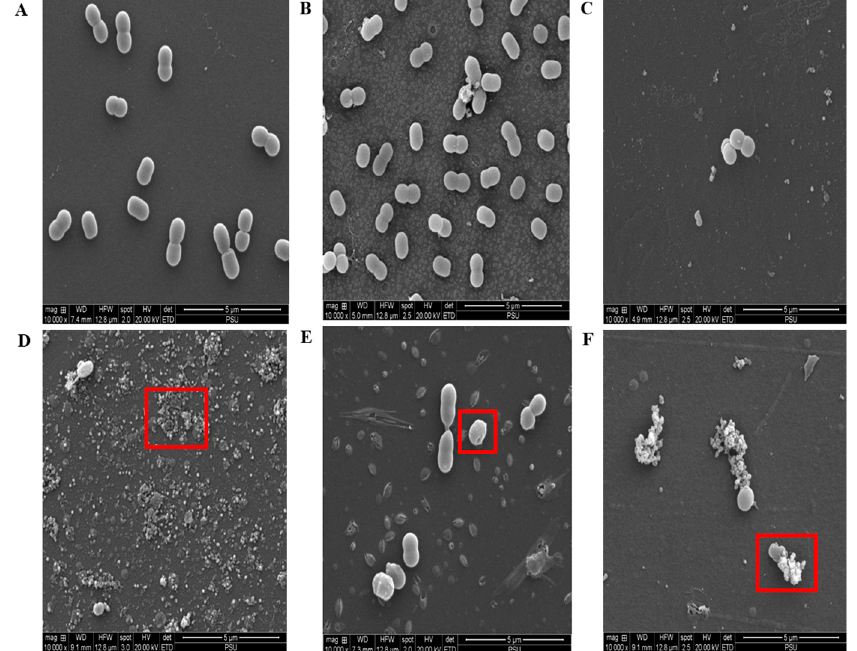
Figure 6. Scanning electron micrograph of the SK024 isolate after 3 h treatment with rifampicin and meropenem alone and in combinations at 10,000 × magnification. ( A ) untreated cells, ( B ) treatment with rifampicin alone, ( C ) treatment with meropenem alone, ( D ) treatment with MIC rifampicin + 1/2 MIC meropenem, ( E ) treatment with 1/2 MIC rifampicin + 1/2 MIC meropenem, and ( F ) treatment with 1/2 MIC rifampicin + 1/4 MIC meropenem.